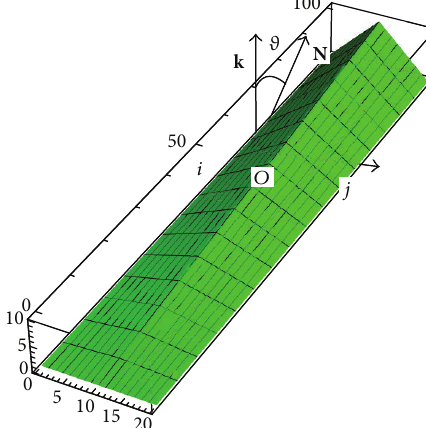
Figure 7: A representative graph for Coons patch for 𝑥 𝑖 = 10 that angle 𝜗 between N and k on Coons patch for 𝑥 𝑖 = 10 is smaller.